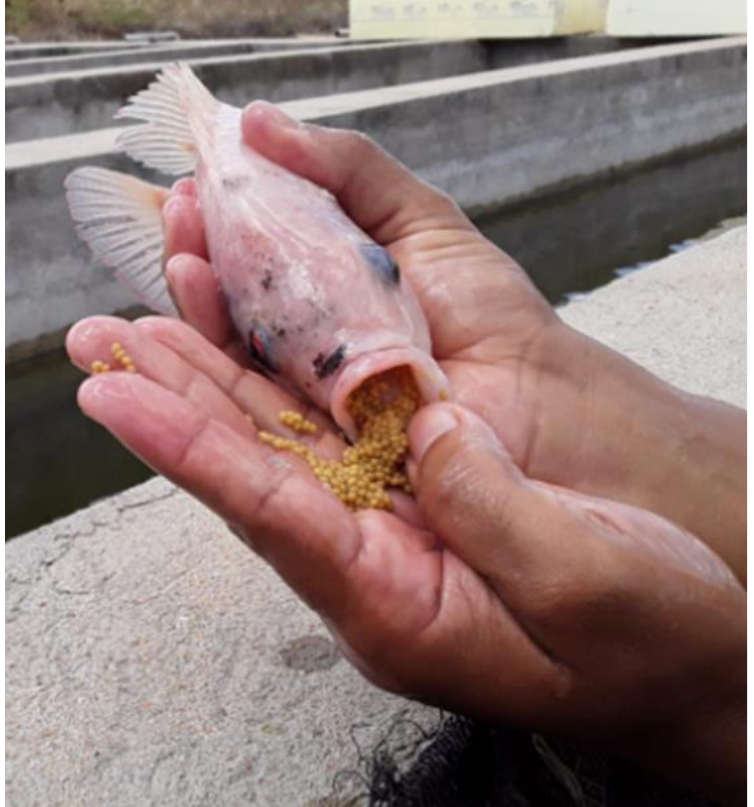
Figure 1. Female red tilapia, Oreochomis sp., protecting the offspring (fertilized eggs incubated in the mouth) during reproduction in masonry tanks at the Fish Farming Station of the Federal Institute of Education, Science and Technology of Ceará – IFCE, Campus Aracati, East coast of Ceará State, Brazil.